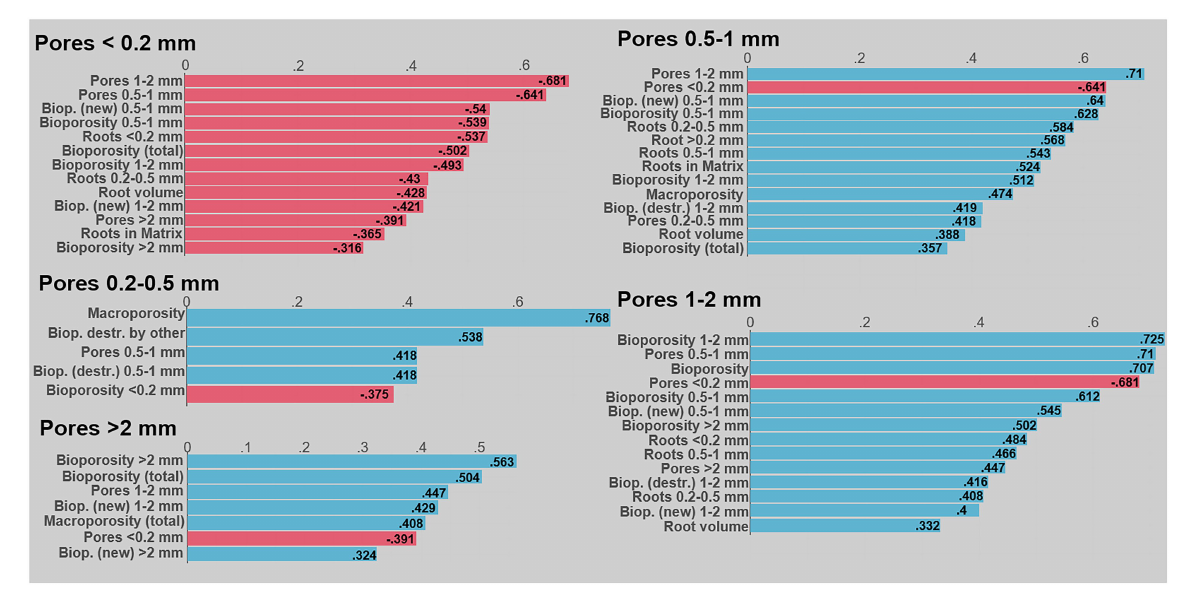
FIGURE 4 Associations between root, biopore, and pore characteristics and volumes of pores in different size classes visualized by Pearson correlation coefficients for the data from the 2nd root growing period. Shown are correlation coefficients significant at <0.1; red mark negative and blue positive correlations. The Biop. (destr) and Biop. (new) are the bioporosity destroyed and created during the 2nd growing period. Biop. (destr) by other are these biopores filled by cast other than earthworm cast (presumably from enchytraeids): Note that these analyses are performed using analyses of CT images after the 2nd root growth period and correlations therefore result from processes of both root growing